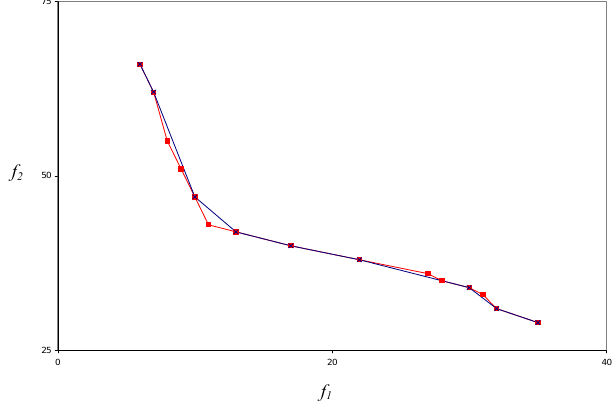
Fig. 1. Makespan vs. Total Operation Costs (MF01-3x4, (Frutos et al., 2010)). MOEA, without Local Search ( ) and with Local Search ( ) The second chromosome represents the sequencing of the i O already assigned to a machine jk J at a given  . We denote with values between 0 and (n!-1) the sequence of M . That is, i j k k (Table 2). The initial values are generated in a random way up from uniform distributions: integer numbers between 0 and m-1, for the allocation chromosome and between 0 and n!-1, for the sequencing chromosome. After that, a crossover and a mutation operator are applied segment-wise on the population of combined allocation-sequencing chromosomes. After some preliminary runs, we selected the Uniform Crossover operator, because it yields the best results. The mutation operator is needed because the crossover alone does not allow reaching certain areas of the search space of the FJSSP. We chose the Two-Swap mutation operator, which takes the chain of integers corresponding to two chromosomes and selects at random two genes, swapping their positions.